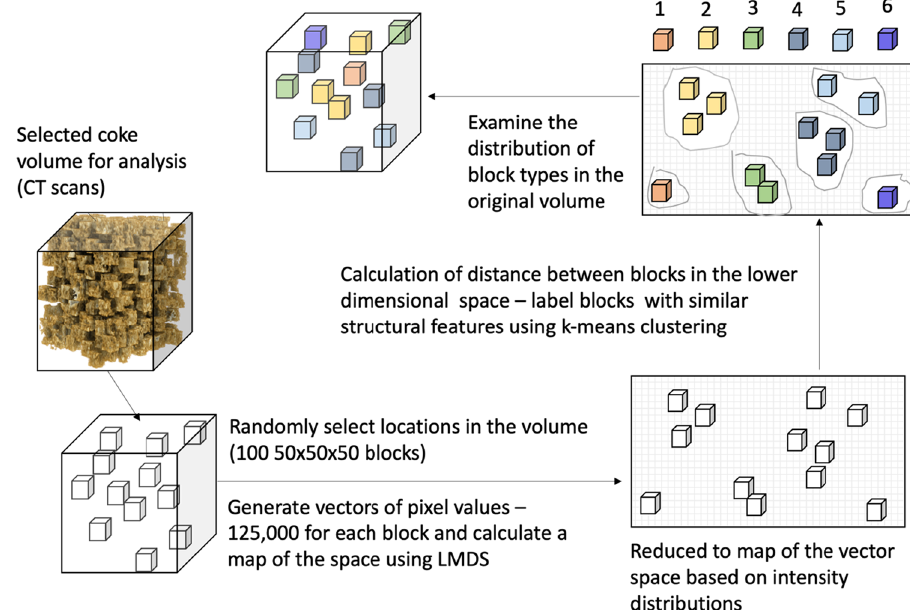
Fig. 5 An overview of the unsupervised classification approach of coke